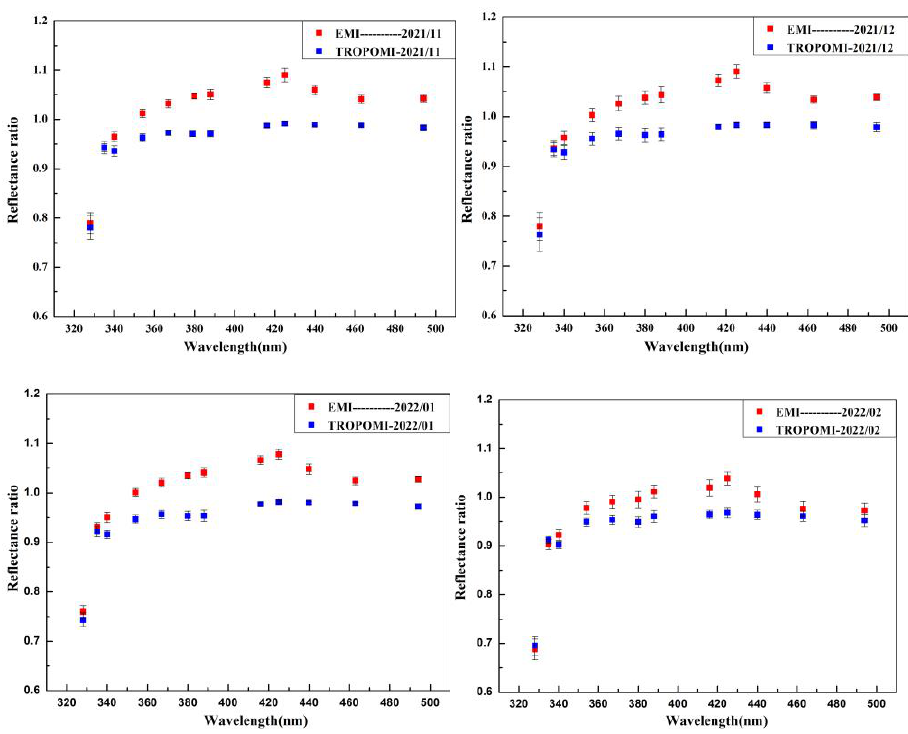
Figure 10. Mean and standard deviation series of atmospheric transmission correction factor of EMI-2 and TROPOMI in different months.